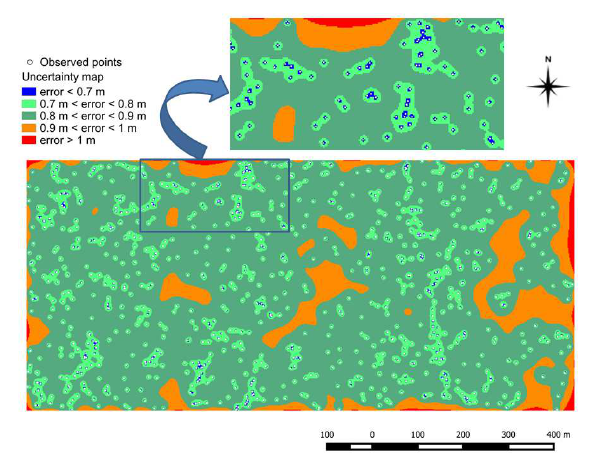
Figure 8. Map depicting the grid DSM vertical uncertainty (estimated values classified according to the map legend).